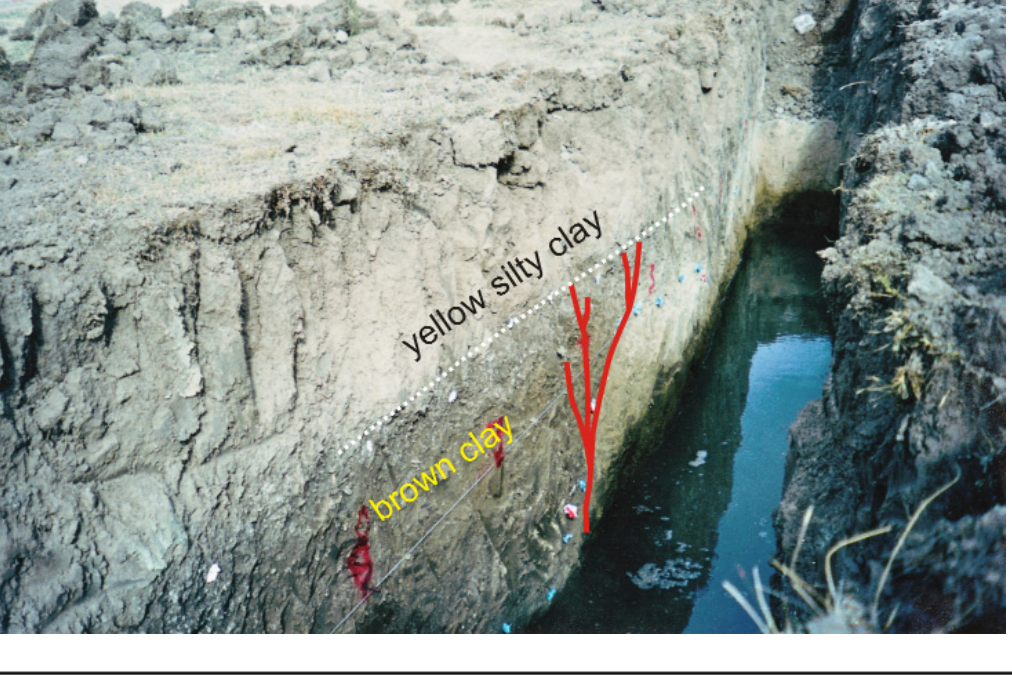
Figure 6 (left). General view of Trench-1 (looking to the north).